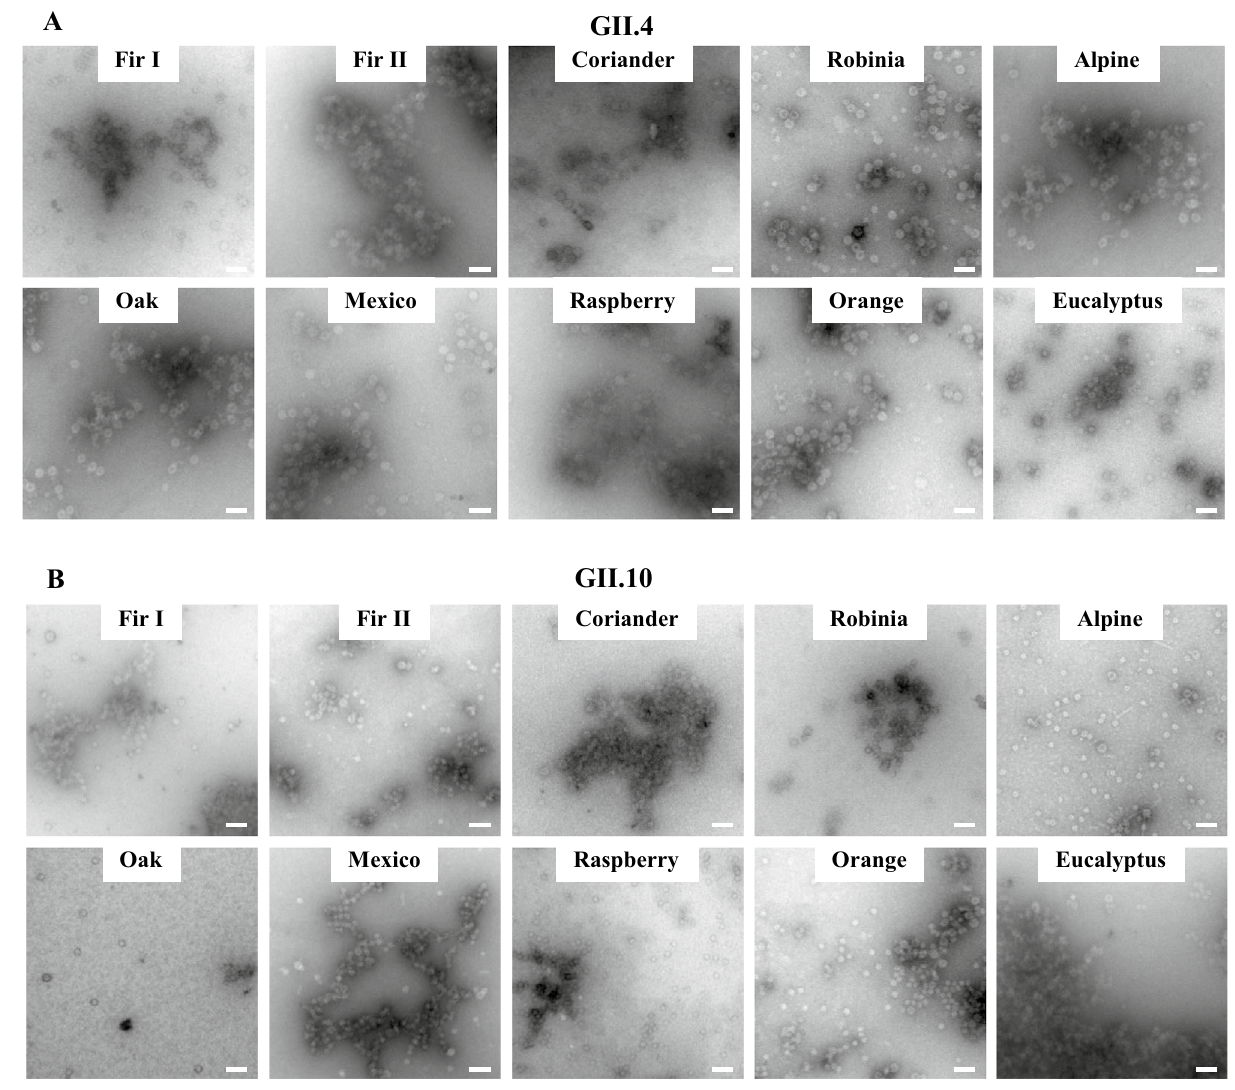
Figure 6. Honey samples and EM analysis of GII.4 and GII.10 VLPs. The integrity of the VLPs upon treatment with different honey samples (final concentration of honey 12.5%) was observed using EM. ( A ) For GII.4, most honey samples caused the VLPs to form small aggregates, in particular Fir II, Oak tree, and raspberry. However, single particles were also observed. ( B ) For GII.10, the VLPs treated with honey samples tended to aggregate, especially for fir I, coriander, Mexico and eucalyptus, although single particles were also found. Scale bar = 100 nm. EM analysis was performed in triplicate and different grid squares were imaged. Representative images of the samples were